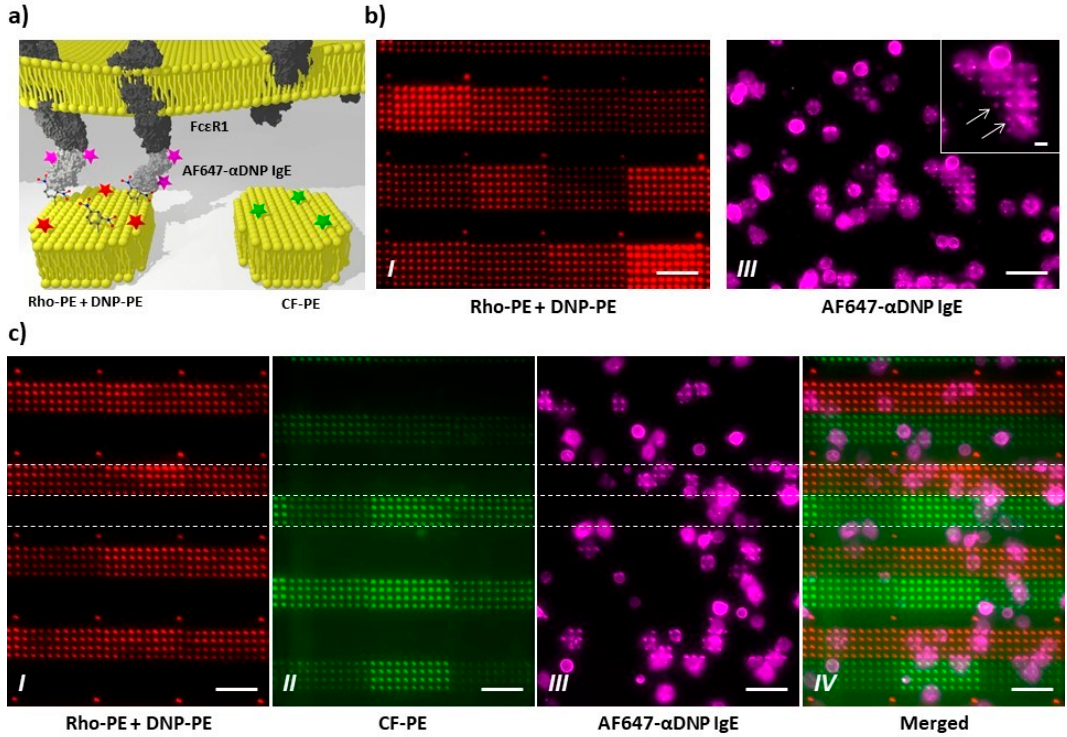
Figure 8. Recruiting of cells on antigen-containing lipid arrays. ( a ) Schematic outline of the performed experiments: RBL2H3 cells were pre-incubated with AF647-labeled anti-DNP IgE antibodies. The excess of antibody was washed away, and the cells were incubated onto previously printed and washed DNP-containing lipid arrays; ( b ) Preliminary experiments to confirm the presence of the antigen DNP in the printed arrays and their accessibility to the specific IgE antibodies; ( c ) Results of the carried experiments. Note that the cells react to the DNP-containing spots by localized spots recognition. In fact, some spots co-localize with region, where the cells accumulate the receptors, indicated by white arrows. All scale bars equal 50 µ